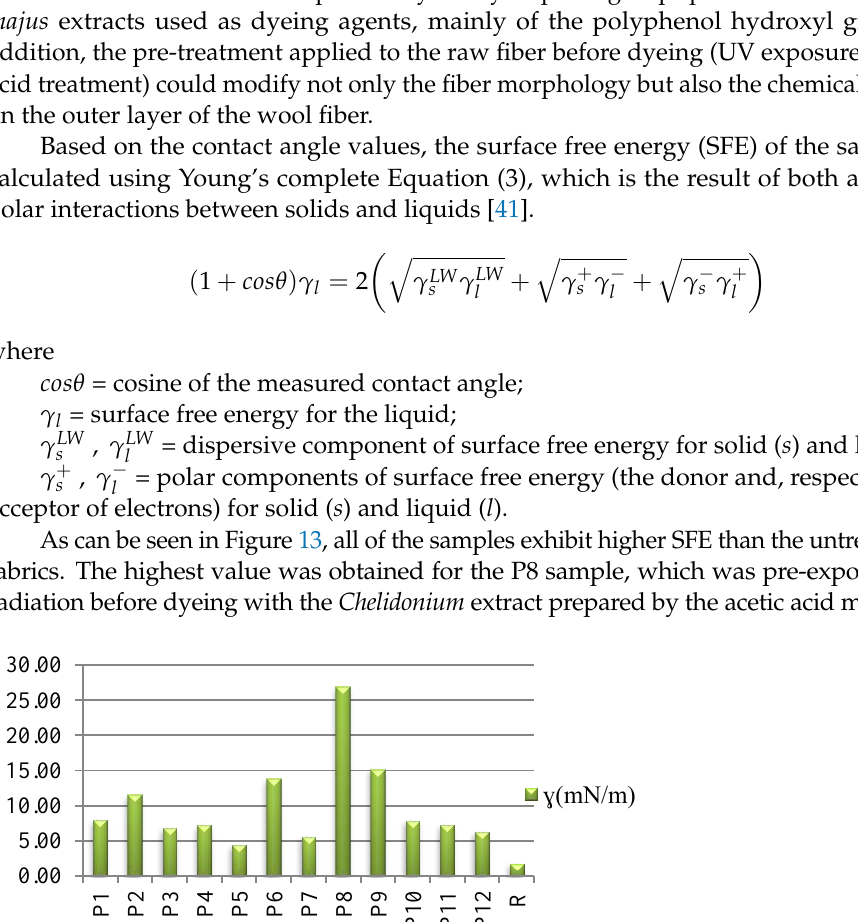
Figure 13. Polar components of surface free energy for wool fabrics, dyed (P1–P12) and raw (R). SFE results from the interactions between the molecules that are present on the outer layer of the wool fibers, and provides information about how the fabrics will behave when coming into contact with the human body [25,42]. The data of an in vivo study evaluating the influence of SFE on fabrics made from cotton and polyester strongly suggest that thermal stress under dry and warm conditions was significantly reduced in subjects who wore clothes and shoes manufactured from fabrics with higher hydrophilic properties com- pared with the group who wore hydrophobic equipment [42]. With respect to fibers and